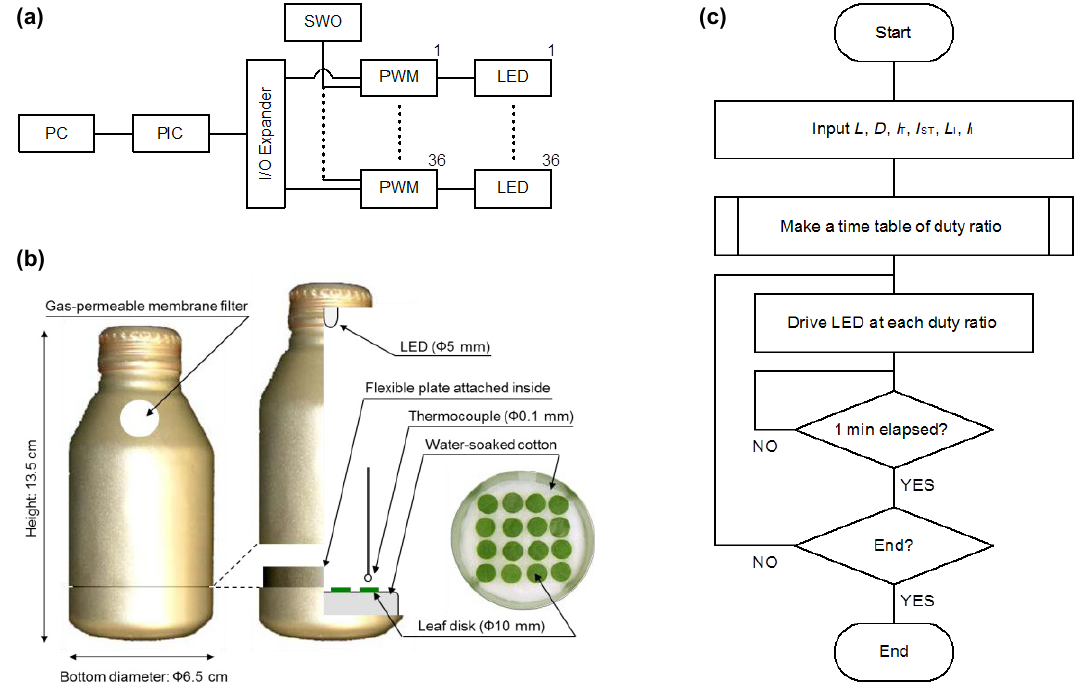
Figure 1. Space-saving photoperiodic bottle system. (a) Schematic diagram of system. PC, netbook computer; PIC, peripheral interface controller; SWO, saw-wave oscillator; PWM, pulse-width modulator (×36); LED, light-emitting diode (×36). (b) Side view and sectional view of bottle, with removable bottom for setting samples. (c) Algorithm of control software. L , light period; D , dark period; I period between beginning of D and beginning of I during I . (Modified from T